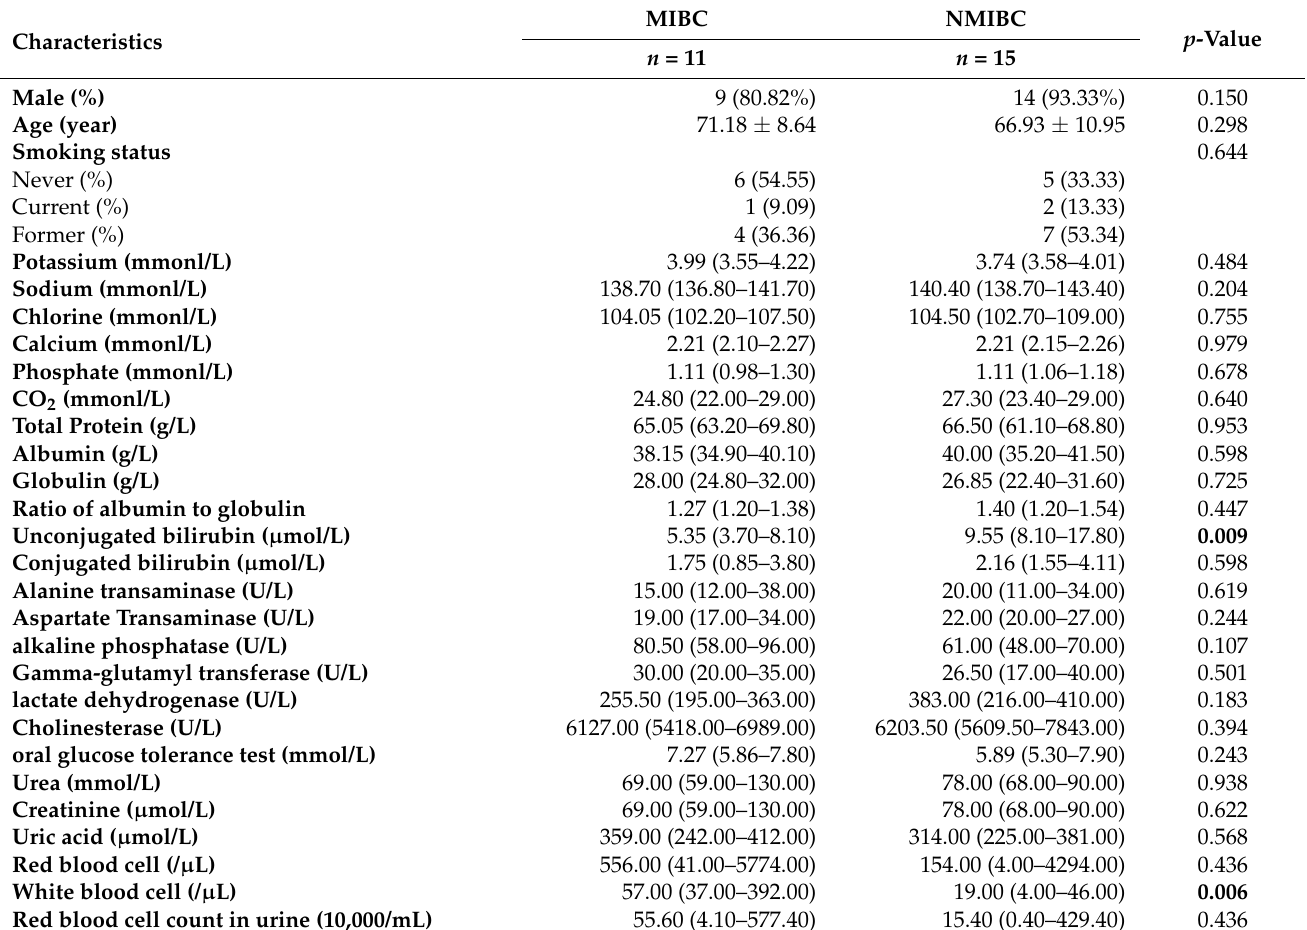
Table 1. Characteristics of included participants in the bladder cancer pilot